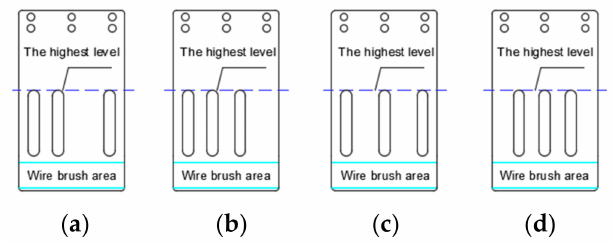
Figure 14. Four different slot positions of the brush